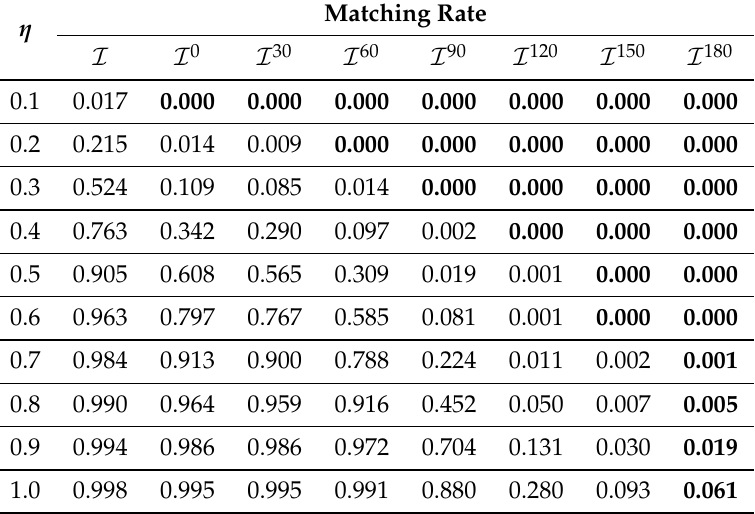
Table 2. Quantitative de-identification results using 3000 matched facial image pairs from LFW dataset [58]. From left to right, η : cosine similarity distance, I : matching rate using original pairs given η , I m : matching rate in which one of the images in the testing pairs is rotated by m